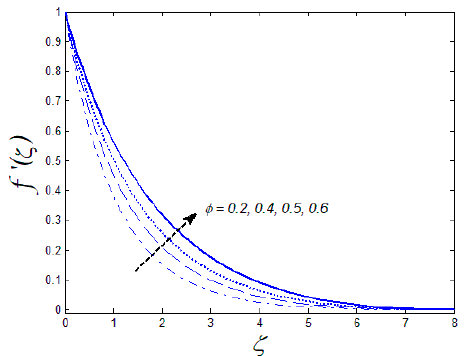
Figure 2. Upshot of φ on velocity distribution f ′ ( ζ ) .